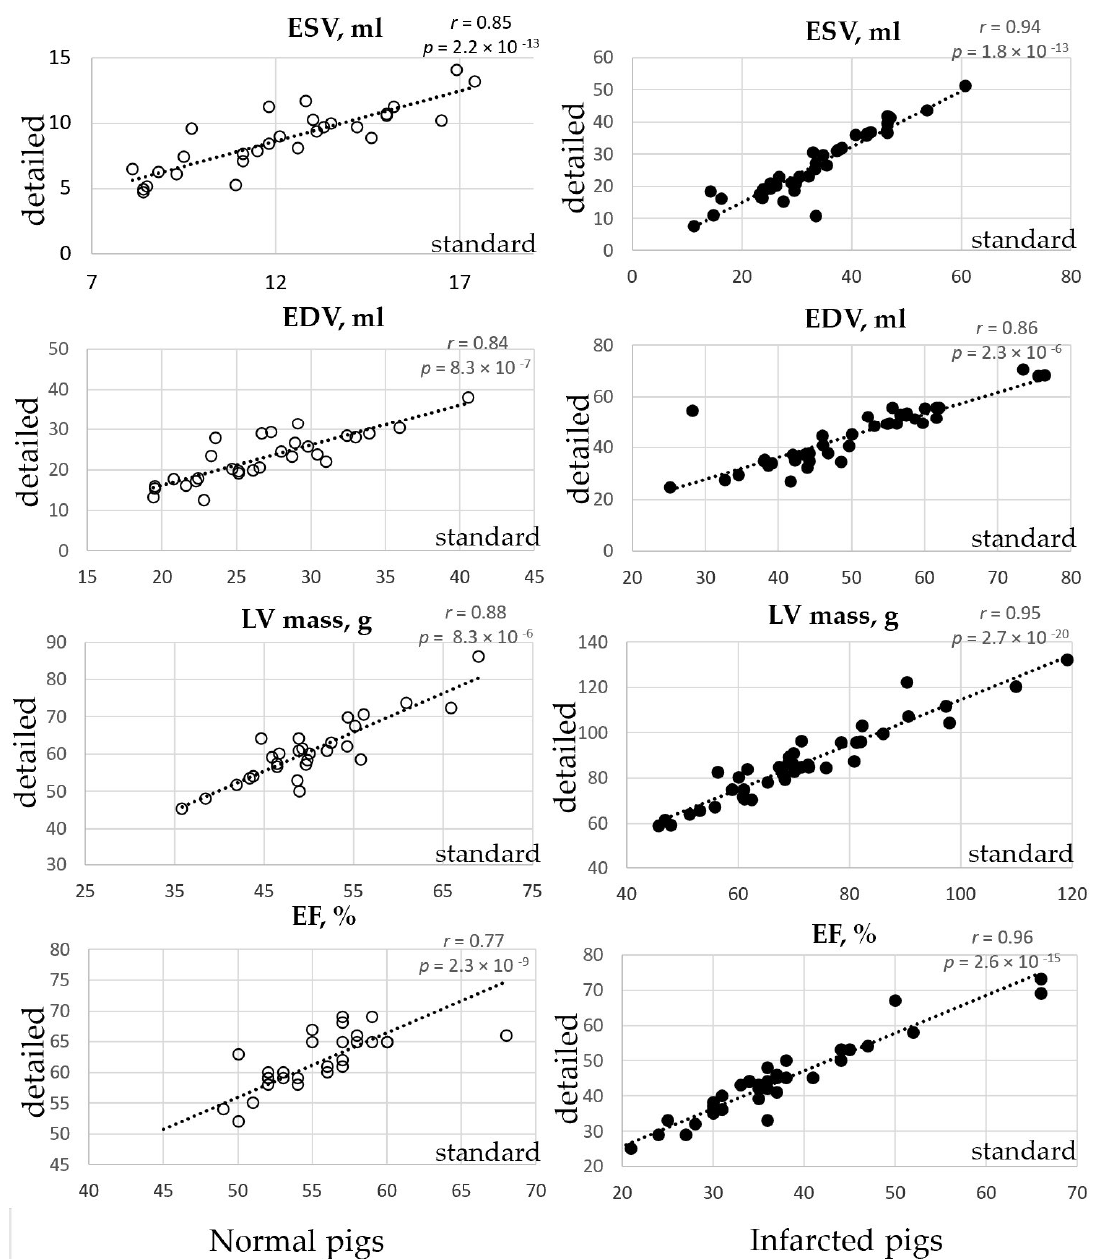
Figure 3. Correlations between the standard and detailed methods of the major volumetric measurements of the left ventricle in the normal ( left column) and infarcted pigs ( right column). Standard measurements are shown on the x-axis, and detailed measurements are shown on the y-axis of all scatter plots.